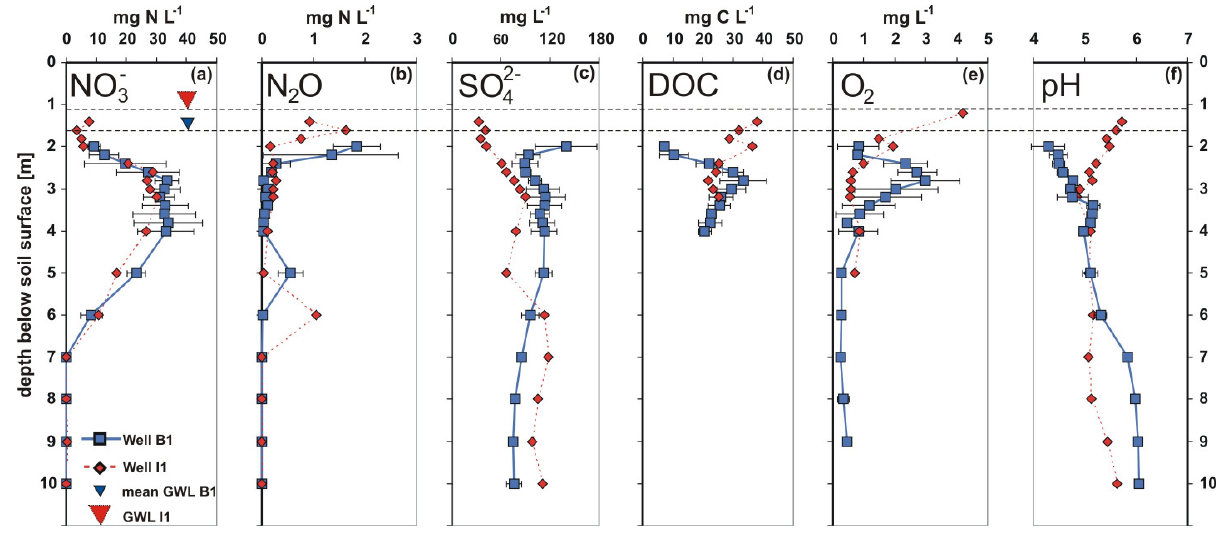
Figure 1: Vertical gradients of NO 3- -, N O-, SO 42- -, DOC-, and O concentrations as well as pH at the wells B1 and I1. The data of well B1 are mean values of three sampling campaigns, the error bars denote the standard deviation (only shown when larger than the symbols). The dotted lines indicate the groundwater level at I1 (GWL I1) and the mean groundwater level of the three sampling campaigns conducted at B1 (GWL B1), respectively.